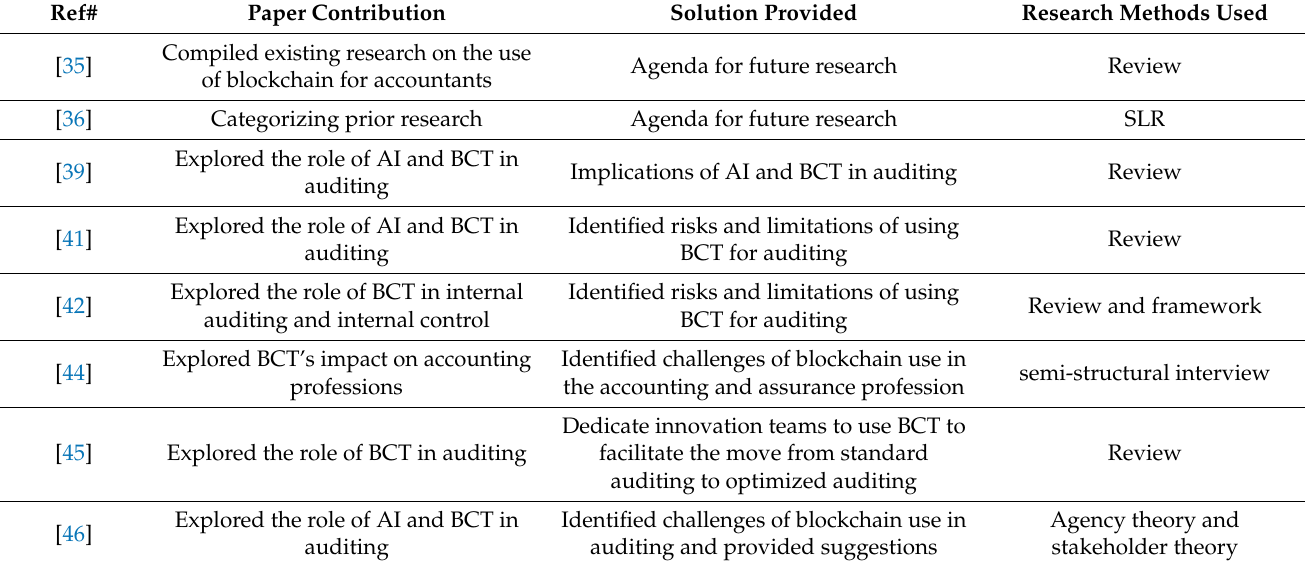
Table 2. Comparison of existing